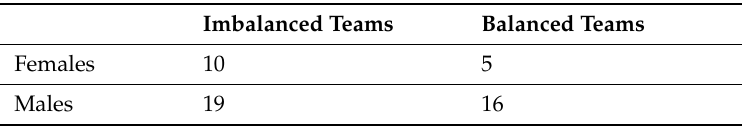
Figure 2. Team formation processes based on the DISC tool.